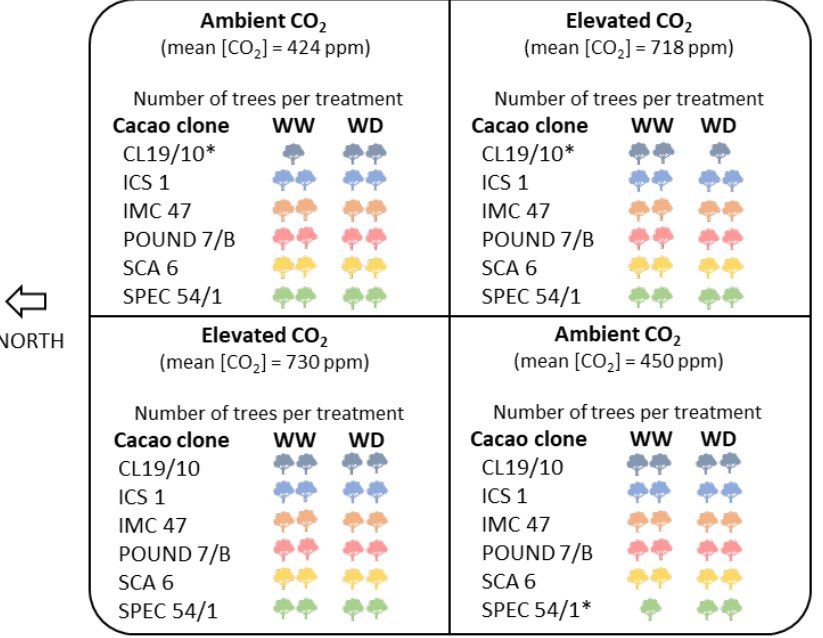
Figure 1. Schematic detailing the experimental setup across the four greenhouse compartments. Two of the four compartments were maintained at close to ambient CO 2 concentrations and two compartments were enriched with CO 2 . Four replicate trees of each genotype were situated in each compartment, two of which were allocated to the well-watered treatment and two were allocated to the water deficit treatment. The genotype and water treatments were randomly allocated within each compartment. * indicates genotypes for which n < 4 in a particular